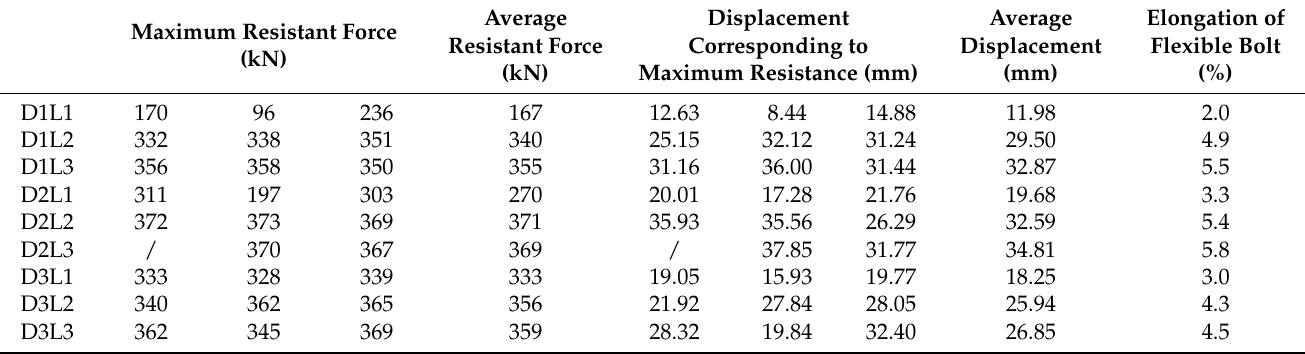
Table 2. Mechanical parameters of flexible bolts with different